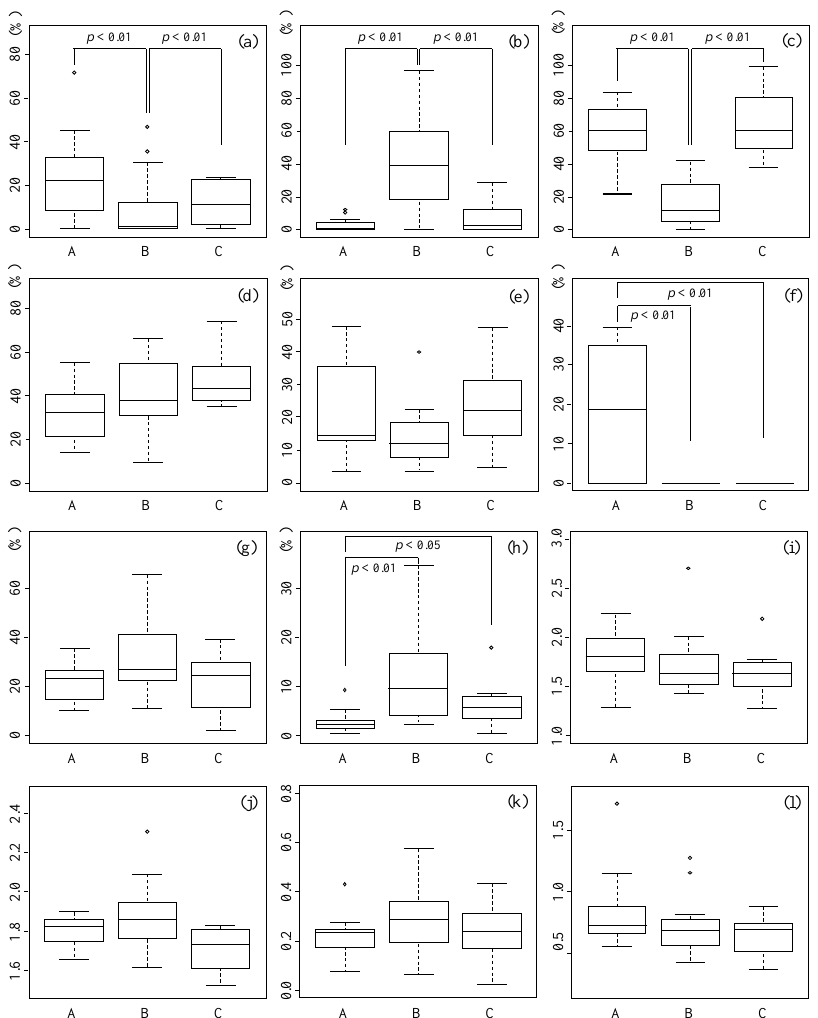
Figure 4. Comparison of controlling factors between groups: ( a ) VR: Volcanic Rock, ( b )PR: Plutonic Rock, ( c ) SR: Sedimentary Rock, ( d ) CF: Coniferous Forest, ( e )BF: Broadleaf Forest, ( f ) MCBF: Mixed Coniferous–Broadleaved Forest, ( g ) CL: Crop Land, ( h ) UA: Urban Area, ( i ) CS: Channel Slope ( j ) TGr Topographical Gradient ( k ) FR: Form Ratio, ( l ) Ro: Roundness.